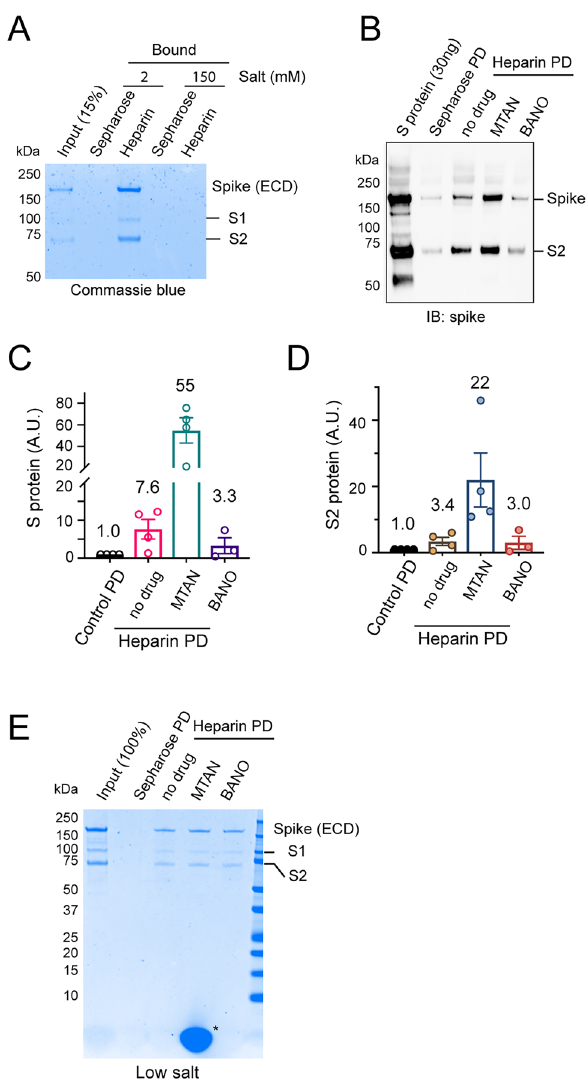
Figure 1. Mitoxantrone affects the spike-heparin interaction. (A) Spike binds to heparin in a salt sensitive manner. Purified spike ECD was incubated with either Sepharose or heparin-coated Sepharose in a buffer containing either low salt (2 mM) or 150 mM salt. Bound proteins and a fraction of input were analyzed by SDS-PAGE and Coomassie blue staining. (B–D) Mitoxantrone but not Banoxantrone enhances the interaction of spike with heparin. (B) Heparin (HP) Sepharose beads were pre-incubated with a buffer in the absence or presence of 50 μM Mitoxantrone (MTAN) or Banoxantrone (BANO). After removing unbound drugs, the beads were incubated with recombinant spike ECD. Proteins precipitated were analyzed by immunoblotting with spike antibodies. PD, pulldown. (C,D) Quantification of the full-length spike ECD (S) or the furin-cleaved spike (S2) in (B) . n = 4 independent experiments. (E) Mitoxantrone does not affect heparin-spike interaction under low salt conditions. As in (B) , except that spike was pulled down in a low salt buffer and that the samples were analyzed by Coomassie blue staining. Asterisk indicates Mitoxantrone bound to heparin